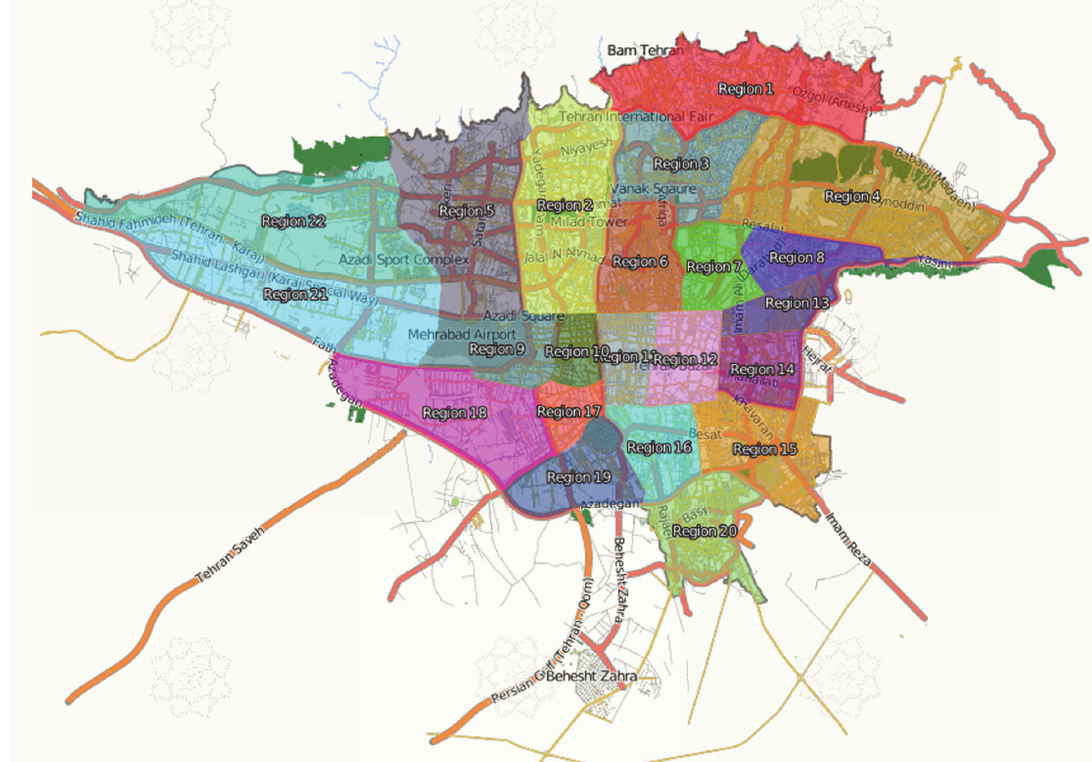
Fig. 5. Twenty-two districts of